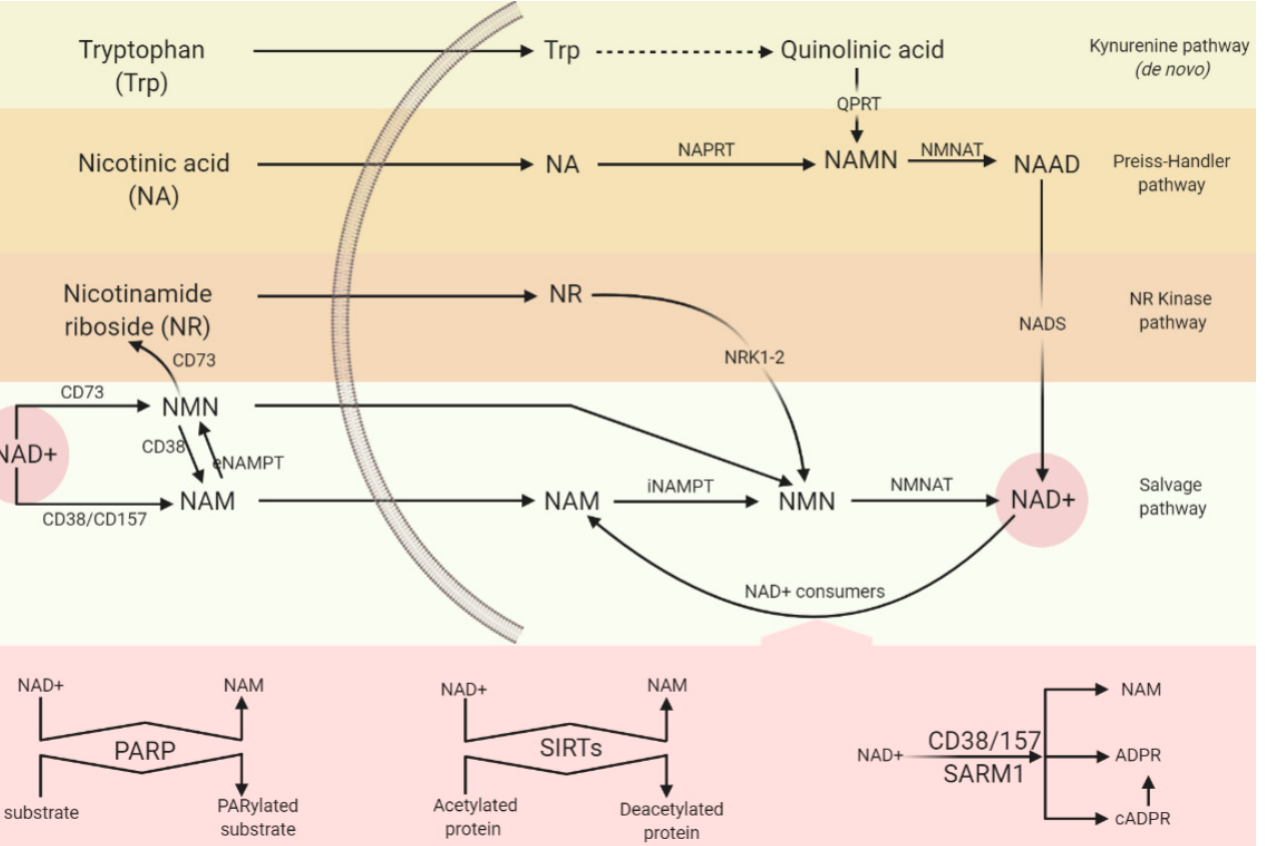
Figure 1. NAD + synthesis and catabolism. There are multiple routes to sustain NAD concentrations within the cell; de novo from tryptophan (Trp), through the Preiss–Handler pathway, or via nicotinamide (NAM) or nicotinamide riboside (NR) salvage pathways. Extracellular is shown to the left of the image, intracellular to the right. NAD + consumption is shown in pink. Legend: Nicotinamide mononucleotide (NMN); extracellular nicotinamide phosphoribosyltransferase (eNAMPT); intracellular nicotinamide phosphoribosyltransferase (iNAMPT); nicotinate phosphoribosyltransferase (NAPRT); nicotinic acid mononucleotide (NAMN); quinolinate phosphoribosyltransferase (QPRT); nicotinic acid adenine dinucleotide (NAAD); nicotinamide riboside kinase 1 and 2 (NRK1 – 2); NAD + synthase (NADS); NA phosphoribosyl – transferase (NAPRT); NAM mononucleotide transferases (NMNAT); poly(ADP – ribose) polymerases (PARP); sirtuins (SIRTs); Sterile alpha and TIR motif – containing 1 (SARM1); cyclic ADP – ribose synthases (cADPR).